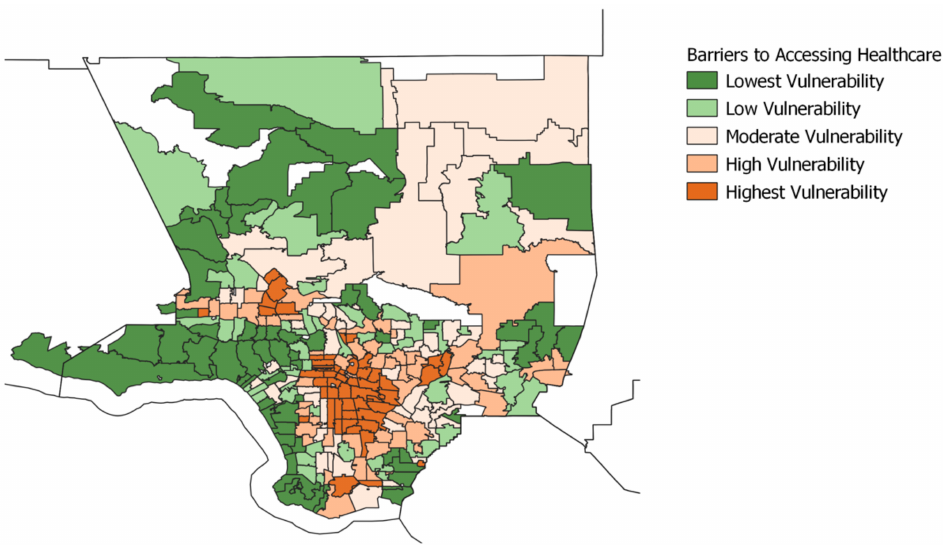
Figure 3. Barriers to accessing health care, Los Angeles County. This figure illustrates the vulnerability due to barriers to accessing health care, which captures barriers that increase difficulty in accessing COVID-19 and other general health care services. The five variables that make up this indicator include non-U.S. citizen status, English language barrier, lack of broadband access, lack of health insurance, and vehicles per person.